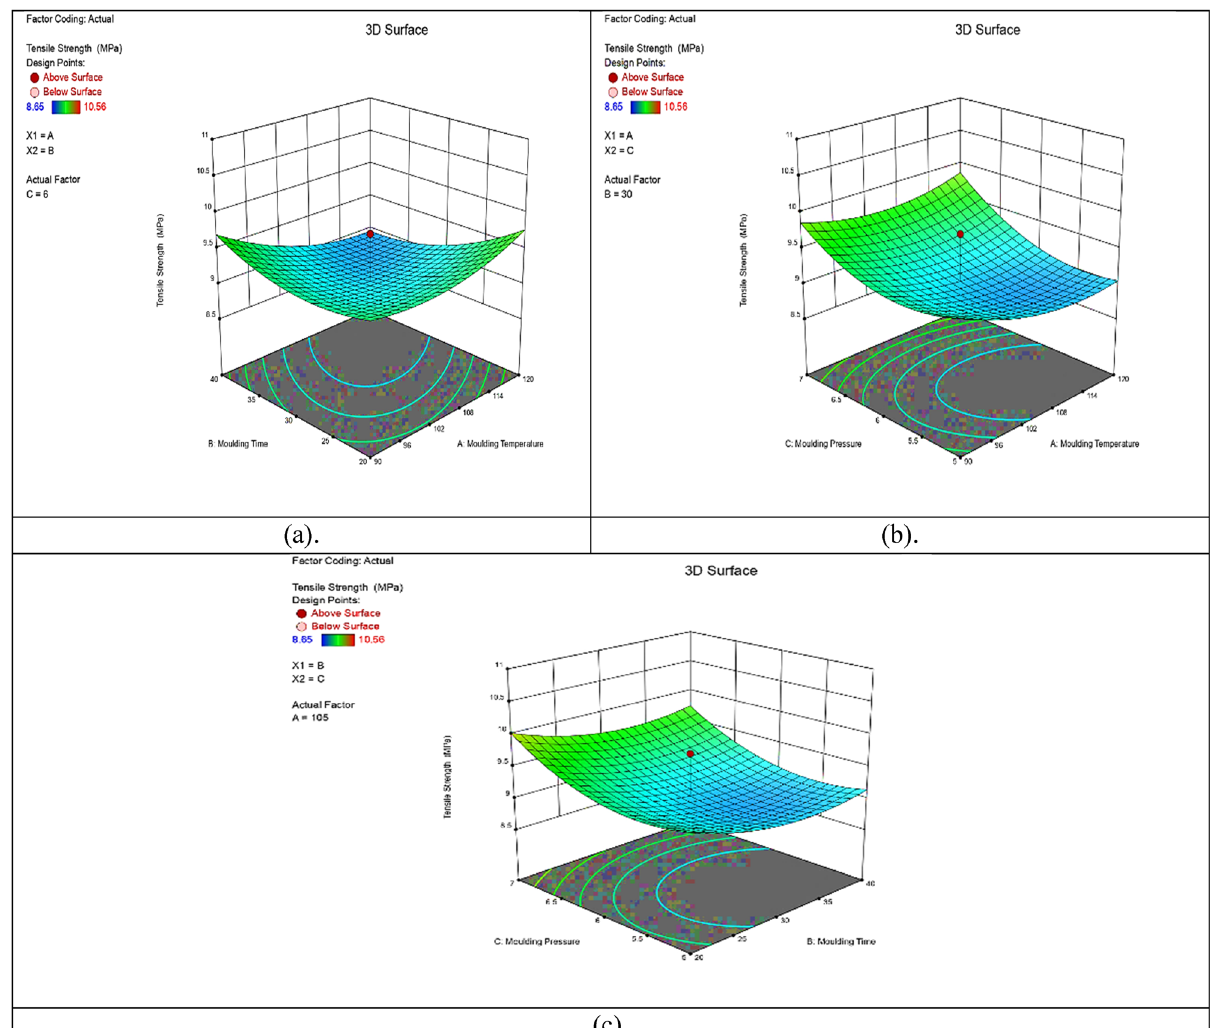
Figure 13: ( a – c ) 3D interaction plots for tensile strength of leather bu ffi ng dust reinforced recycled EVA polymer